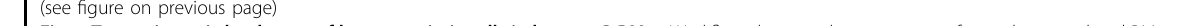
Fig. 1 Transcriptomic landscape of hematopoietic cells in human G-BM. a Work fl ow showing the processing of paired unstimulated BM and G- CSF-primed BM (G-BM) samples from healthy donors for scRNA-seq. b Uniform manifold approximation and projection (UMAP) visualization of main lineages in human BM based on single-cell transcriptomes. Each dot represents a single cell; colors indicate cell clusters with numbered labels. c UMAP visualization of the expression of lineage-speci fi c marker genes (top) and activity of canonical cell type-speci fi c regulons (bottom) in identi fi ed cell lineages. d Bar plot showing the changes in the percentage of each cell lineage upon G-CSF treatment. Pre, representing samples before G-CSF treatment; Post, representing samples after G-CSF treatment. e Dot plot showing average expression of top 10 DEGs for hematopoietic cells in unstimulated BM and G-BM and the percentage of cells expressing the genes. DEGs were detected using function FindAllMarkers in Seurat (Wilcoxon-rank-sum test, with P value adjusted for multiple testing using Benjamini – Hochberg correction). f Bar plots from the Metascape analysis showing the major enriched terms of DEGs before (top) and after (bottom) G-CSF administration. The length of each bar represents – log 10 ( P